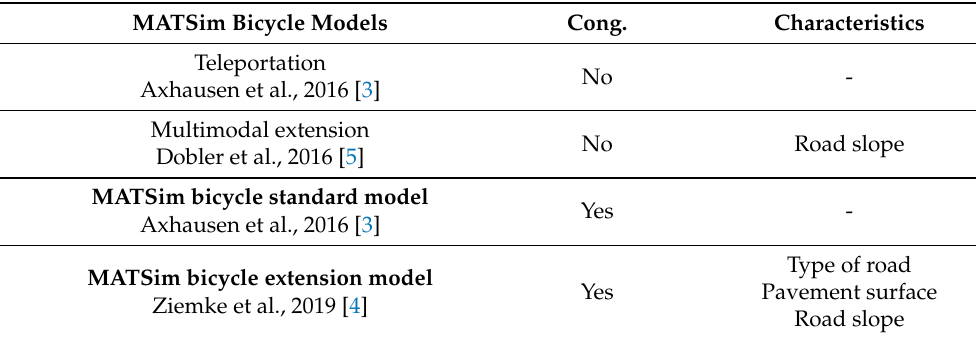
No - No Road slope Yes - Type of road Pavement surface Yes Road